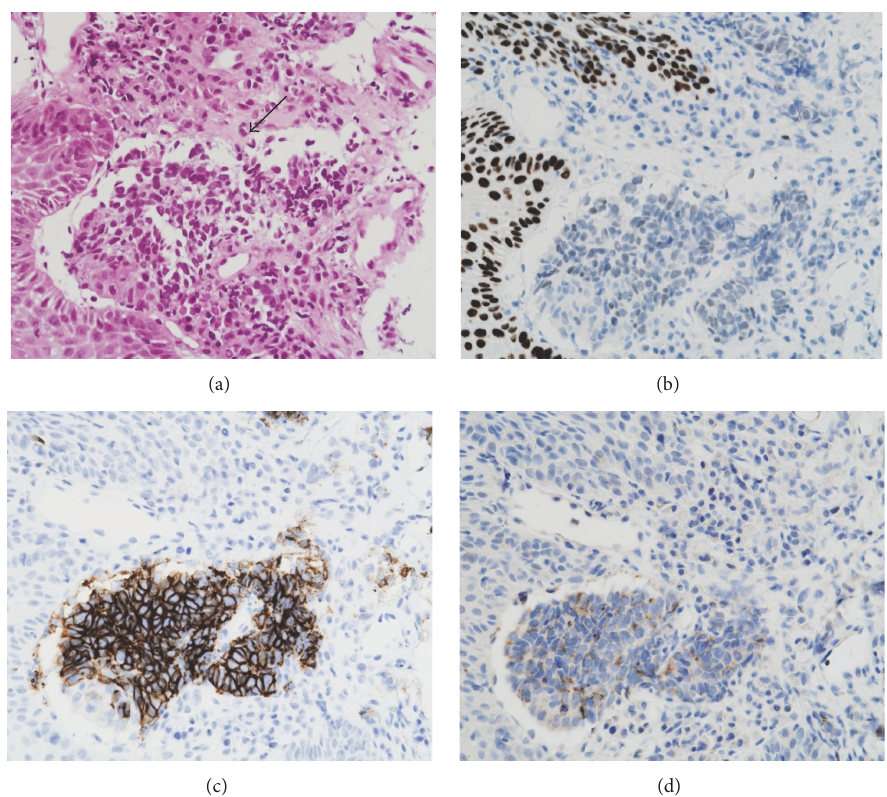
Figure 2: Histopathological and immunohistochemical features of the combined SmCC and SCC of the hypopharynx. (a) This tumor consists of a mixture of SmCC (center, arrow) and SCC (peripheral) (hematoxylin-eosin, original magnification 400x). (b) The p63 reactivity is seen in the nuclei of the cells of SCC but is not seen in SmCC component. (c) The CD56 reactivity in SmCC component is seen but is not seen in SCC component. (d) Chromogranin A shows positive cytoplasmic staining in SmCC component.